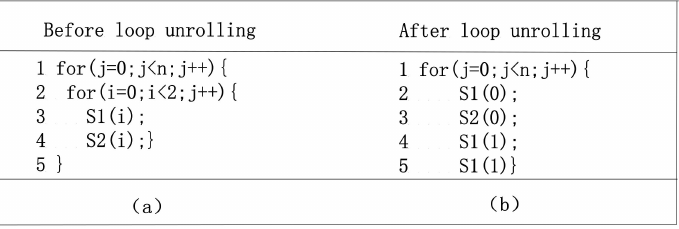
Figure 1. Loop unrolling transformation. ( a ) Before loop unrolling; ( b ) After loop